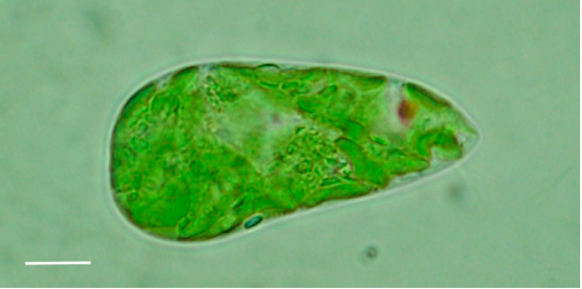
Figure 1. Optical microscopy image of Euglena gracilis wild type, showing its photosynthetic machinery. Bar: 10 µ m.